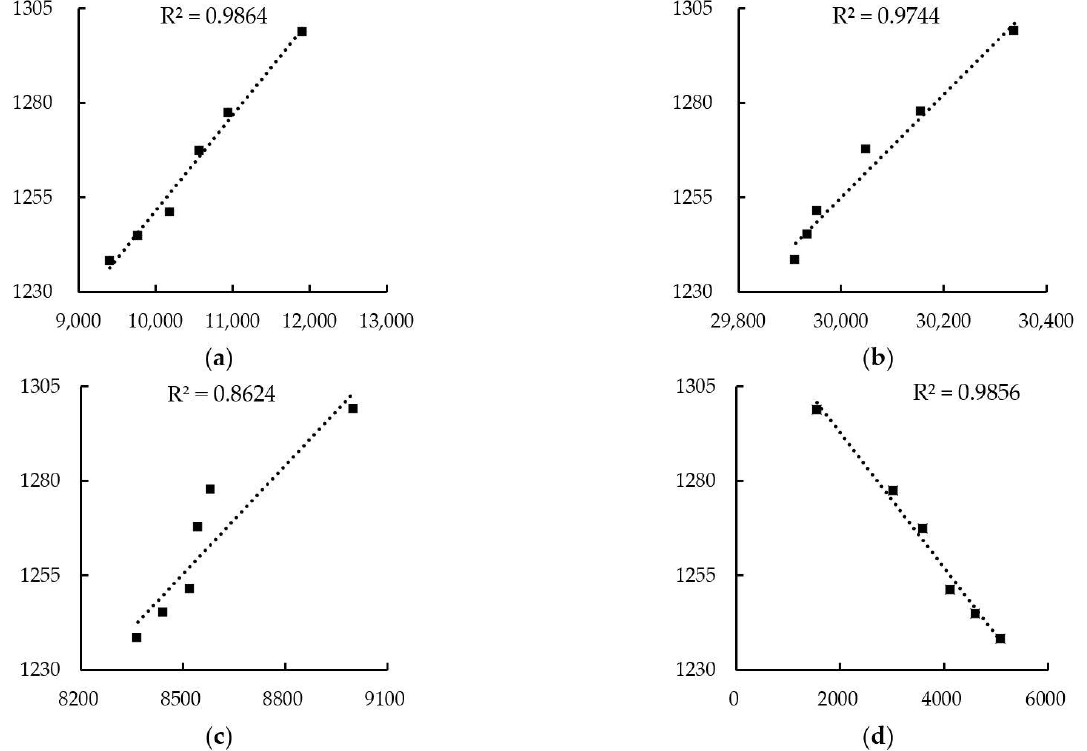
Figure 11. Regression analysis of the change in landscape area of cultivated, woodland, grassland and construction land and total ecosystem service value (ESV). ( a ) Cultivated land area and total ESV; ( b ) Woodland land area and total ESV; ( c ) Grassland land area and total ESV; ( d ) Construction land area and ESV.